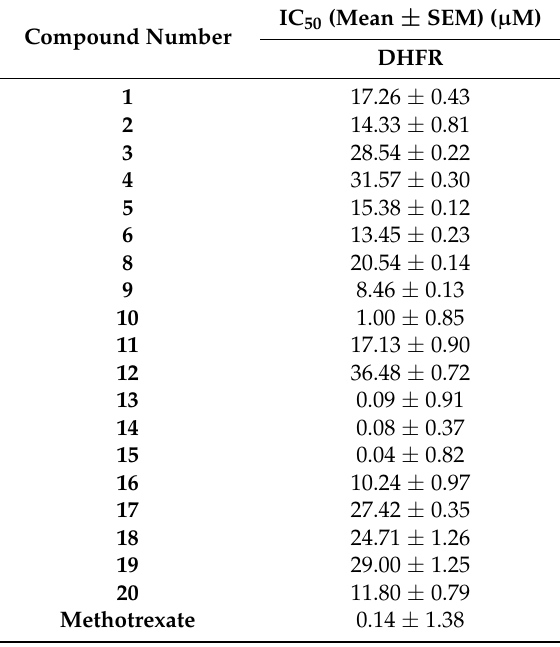
Table 3. In vitro inhibitory activities of the tested compounds 1 – 20 against DHFR